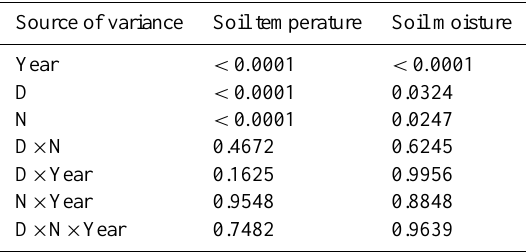
Table 1. Results ( P -values) of three-way ANOVAs on the effects of day (D) and night (N) warming and their interactions on soil tem- perature and soil moisture over the four experimental years (2006– 2009).